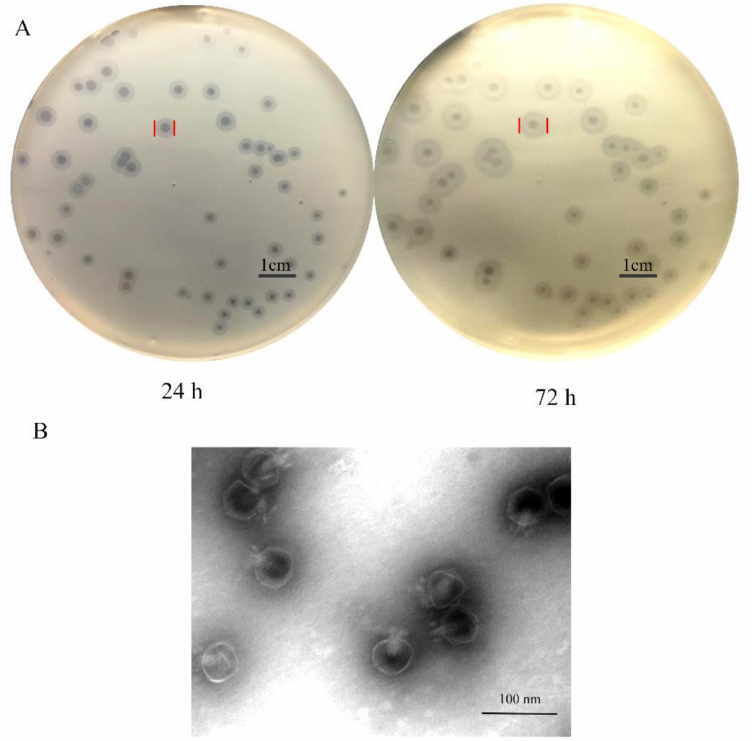
Figure 1. Plaques and morphological analysis of K pneumoniae phage SH-KP152410. ( A ) K. pneumoniae strain 2410 was infected with phage SH-KP152410 and the mixture was poured on the 0.75% agar and then incubated on the 1.5% agar plates at 37 ◦ C. Plaques were observed in soft agar at 24 h and 72 h after infection. ( B ) Transmission electron micrographs of the K. pneumoniae phage SH-KP152410. Scale bar: 50